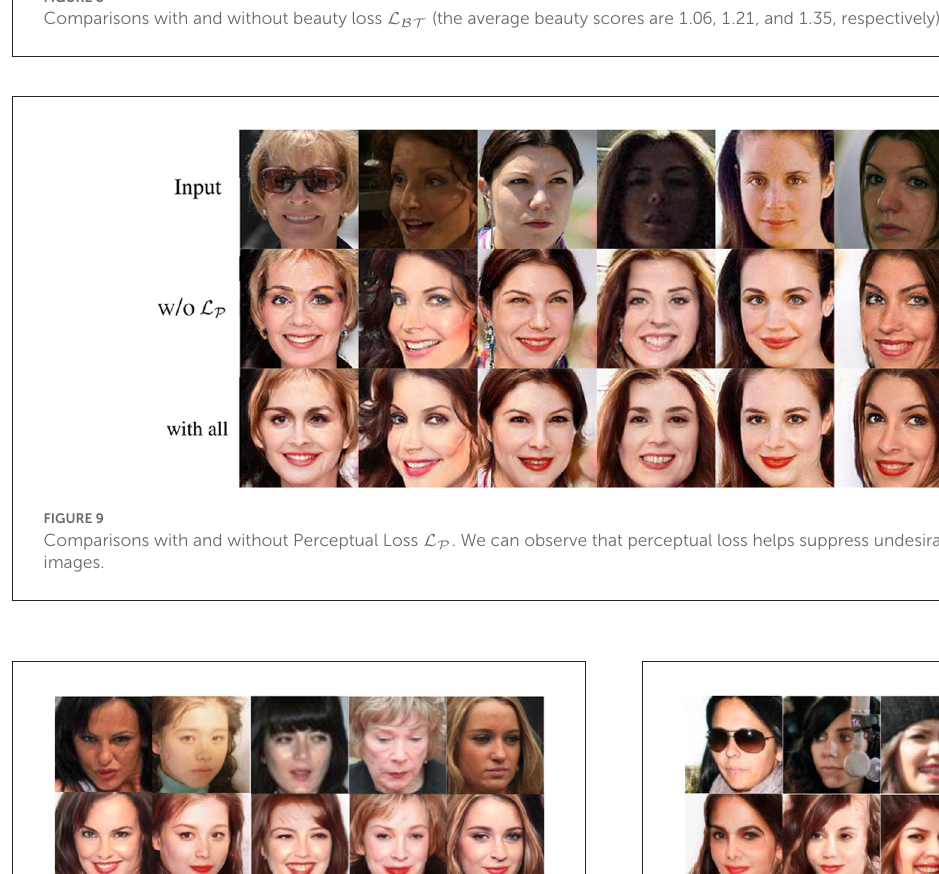
FIGURE10 Our model is robust to low-quality images and small pose variations.